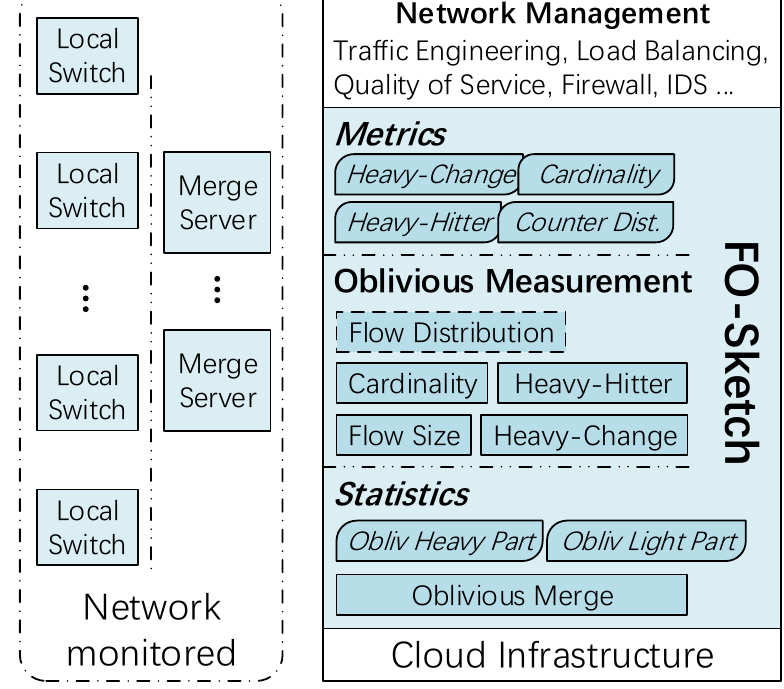
Figure 1. FO-Sketch works for a large-scale network and provides an oblivious network measurement service in a public cloud infrastructure via mergeable sketch and SGX-enabled oblivious functions. Trusted components (software and regions of memory) are